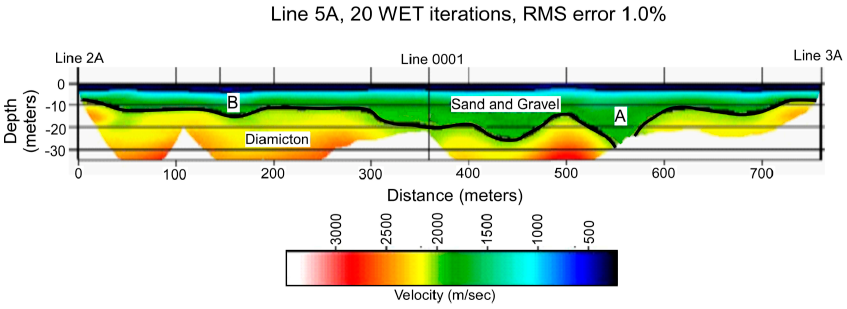
Figure 13. Seismic velocity profile of Line 5A, west is to the left. A = main channel; B = smaller channel on the terrace.